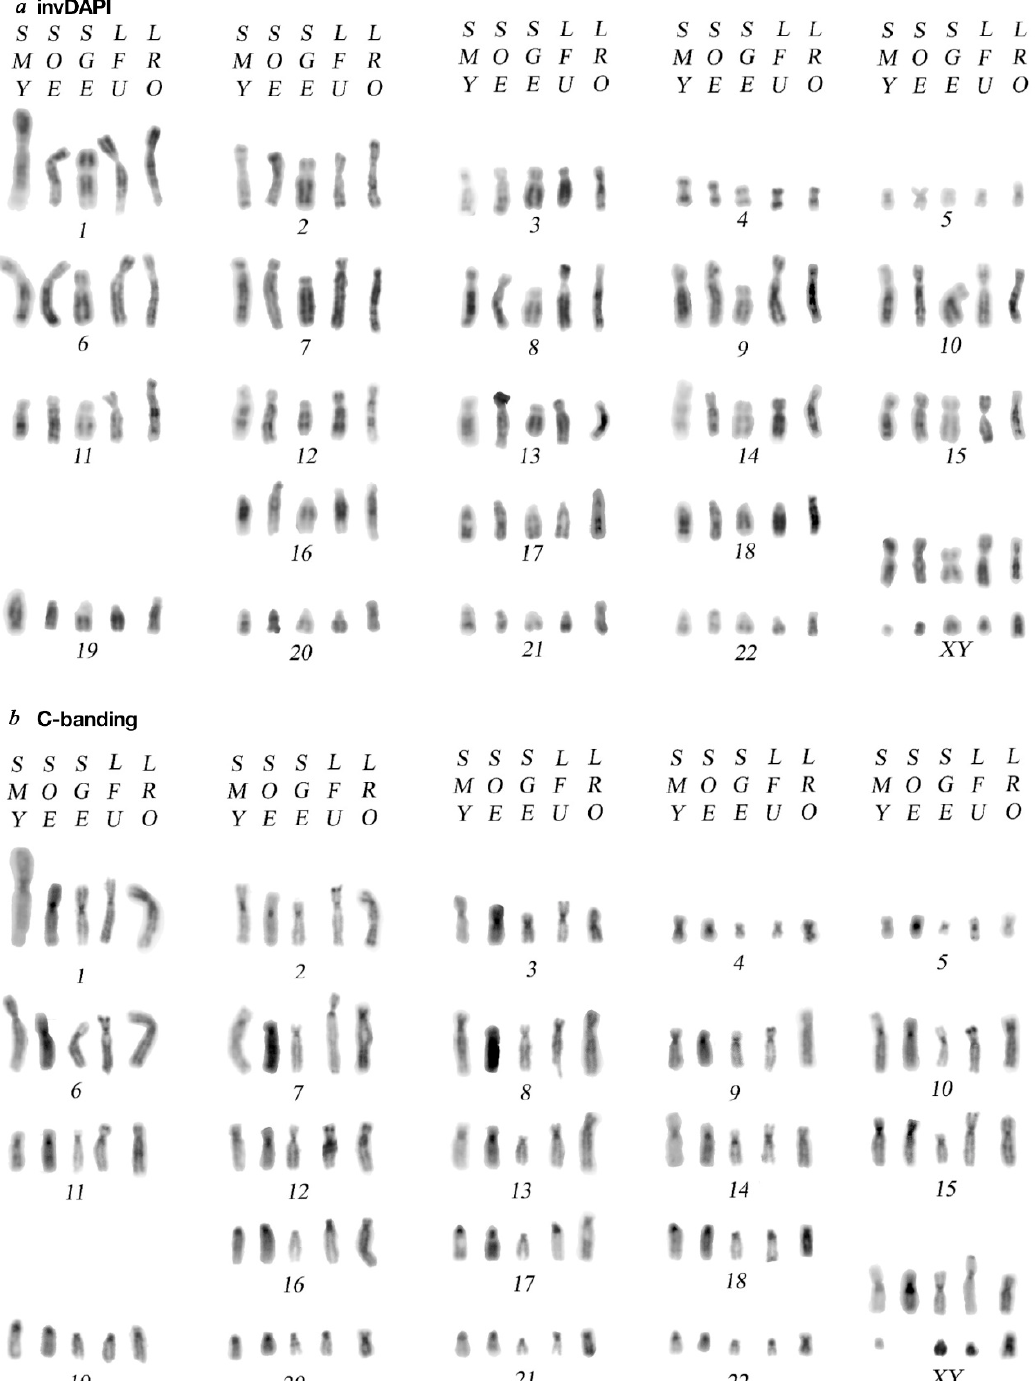
Figure 1. Comparative series of inverted DAPI banded ( a ) and C-banded chromosomes ( b ) of the analysed species: Leon- tocebus fuscicollis, Leontopithecus rosalia, Saguinus geoffroyi, S. mystax and S. oedipus .